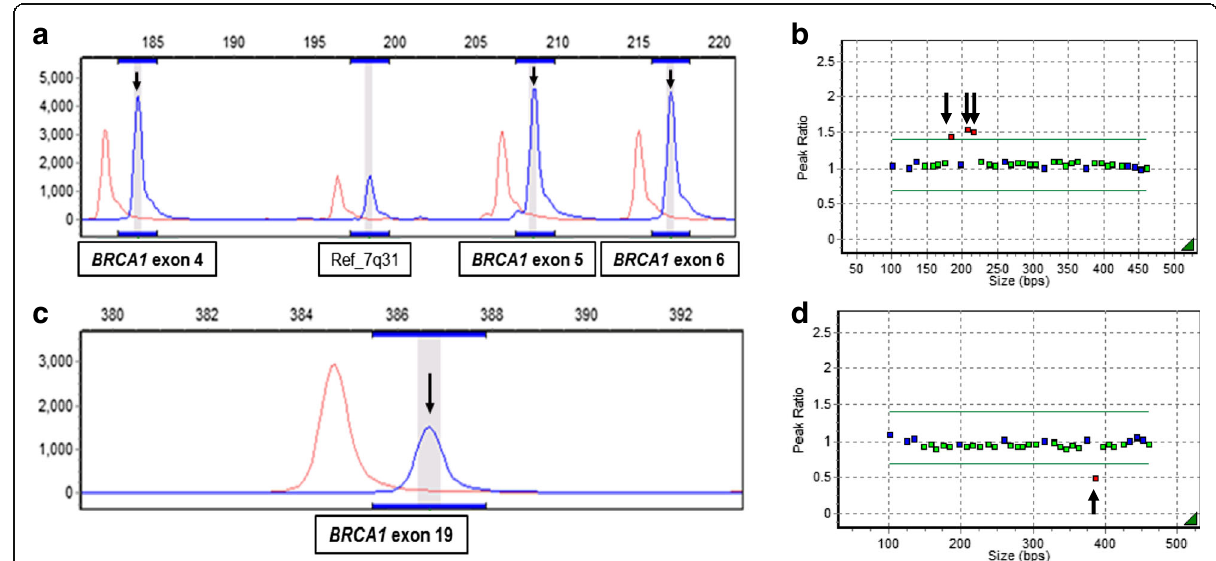
Fig. 2 The 2 BRCA1 LGRs identified in the study using MLPA. ( a , b ) MLPA analysis of the patient who carries duplication of BRCA1 exon 4-6. ( c , d ) MLPA analysis of the patient who carries deletion of BRCA1 exon 19